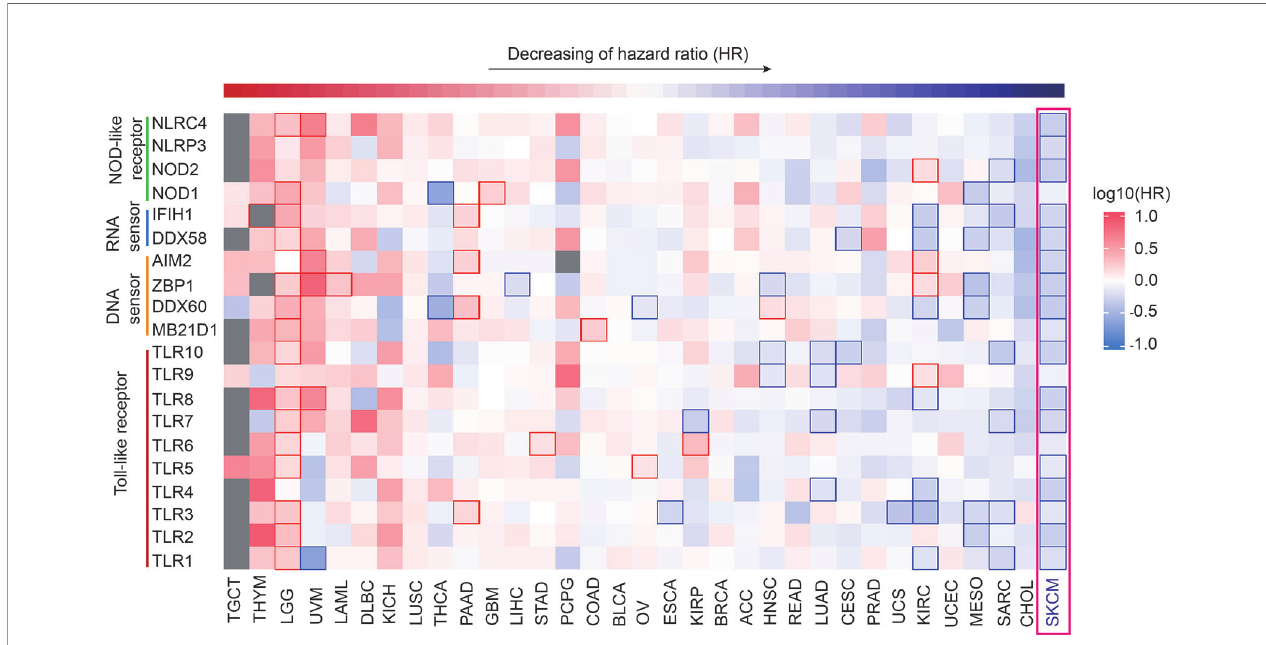
FIGURE 1 | Pan-cancer prognosis analysis of PRRs. Pan-cancer prognosis analysis of PRRs by GEPIA2 shows PRRs family have the speci fi c positive prognosis ability in SKCM (33 tumor types, 9502 samples, the square frame of some samples means P value <0.05 in this prognosis analysis of the indicated